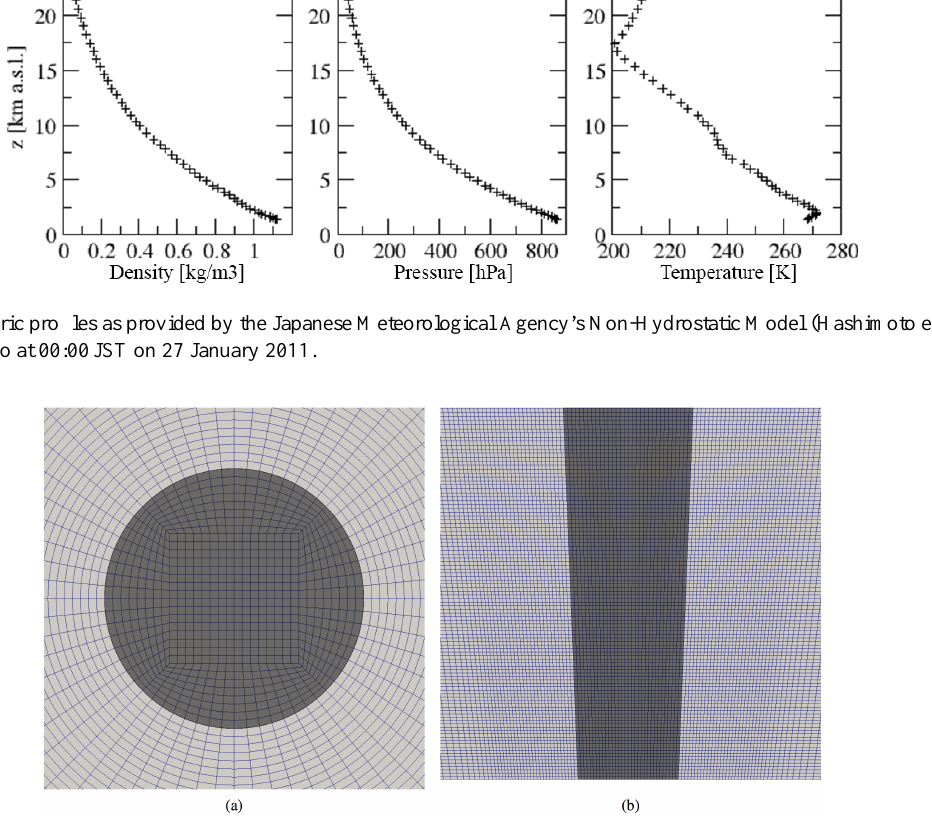
Figure 17. Close-up of the computational grid used for volcanic plume simulations.